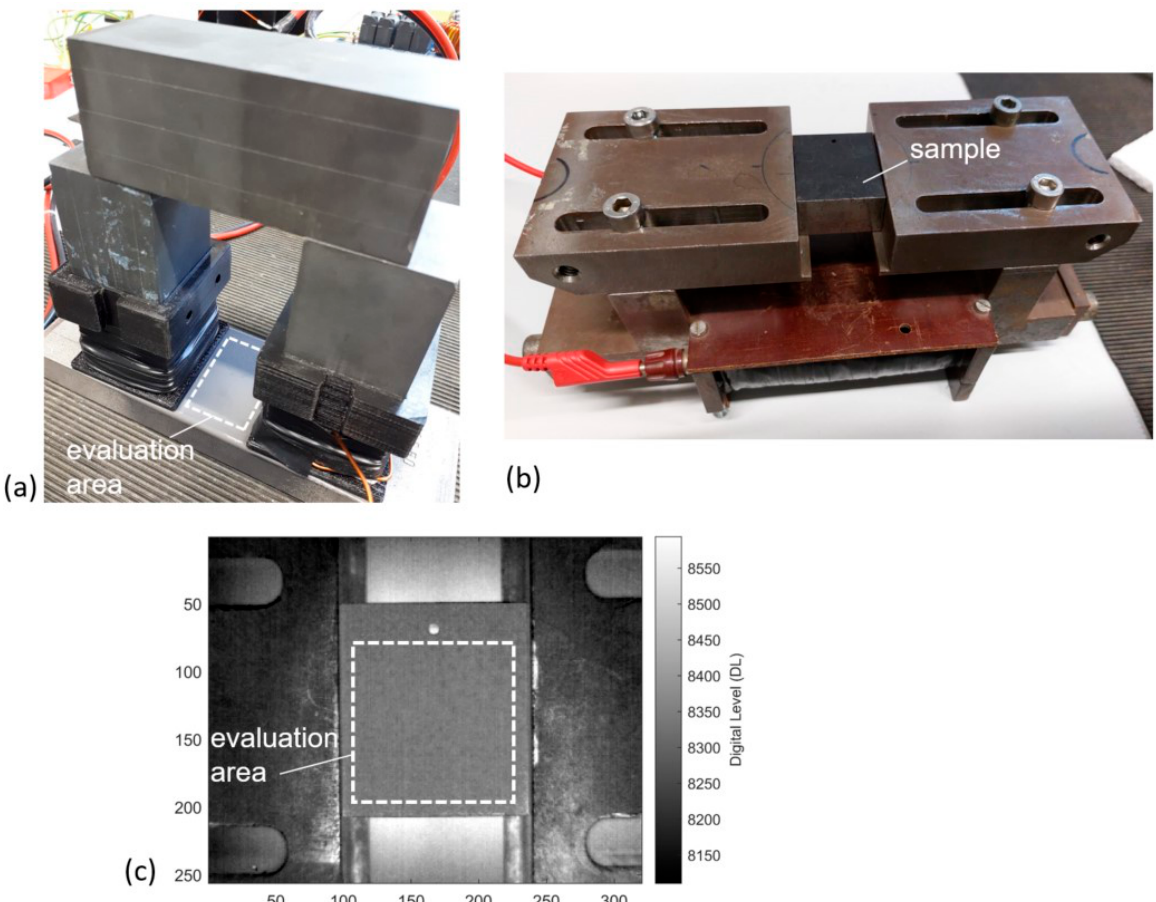
Figure 3. ( a ) Photo of the inductor for the kHz range experiment with the sample underneath and marking of the evaluation area. ( b ) Photo of the inductor for the low-frequency experiment with the sample between the adjustable yokes. ( c ) Thermographic image of the sample in ( b ) with marking of the evaluation area.